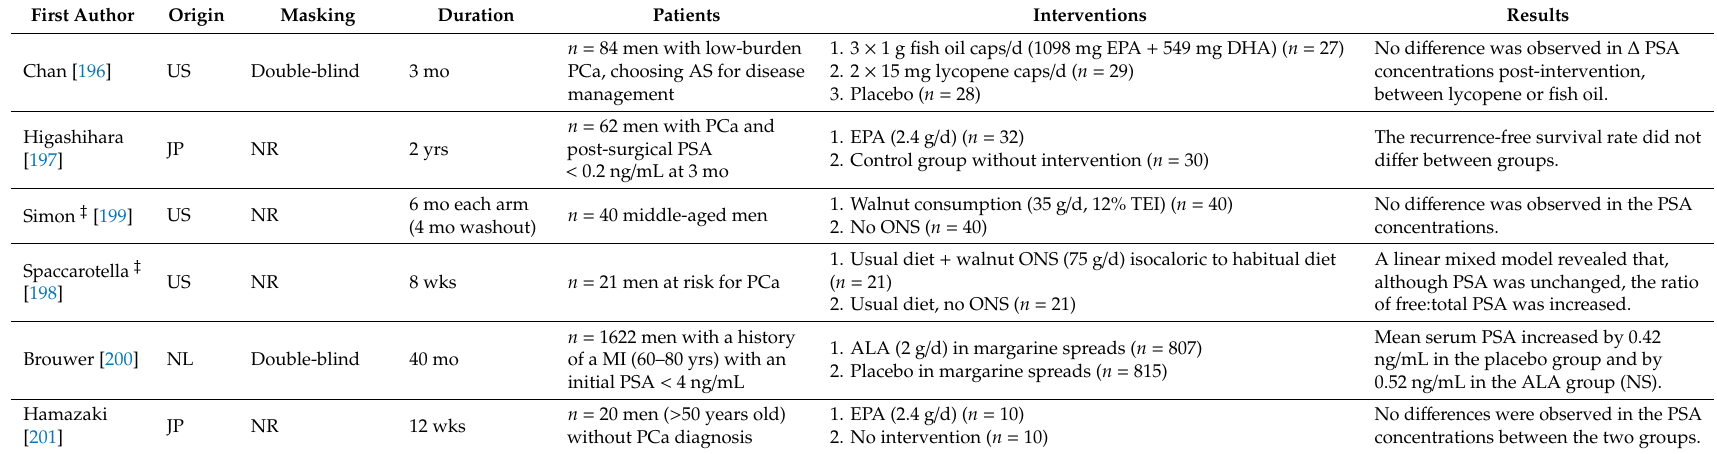
Table 10. RCTs examining the e ff ect of fatty acids supplementation, or frequent intake of foods rich in fatty acids, on serum PSA concentrations among men with PCa or increased PCa